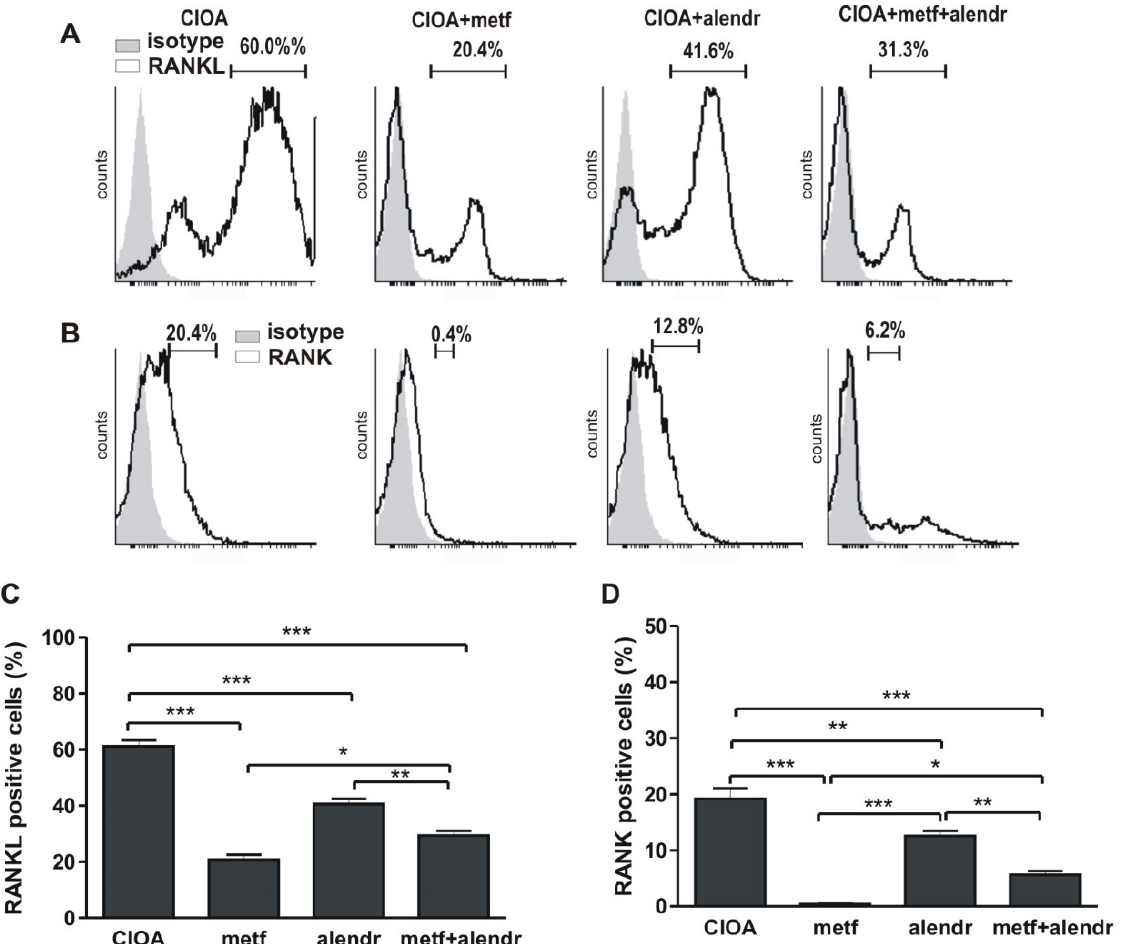
Figure 1. Flow cytometry data. ( A ) Percentage of RANKL+ cells. ( B ) Percentage of RANK+ cells. ( C ) Figure data of ( A ). ( D ) Figure data of ( B ). Data are means ± SD from three determinations ( n = 10 per group). * p < 0.05; ** p < 0.01, *** p < 0.001, one-way ANOVA. (CIOA = collagenase-induced osteoarthritis; metf = metformin; alendr = alendronate).